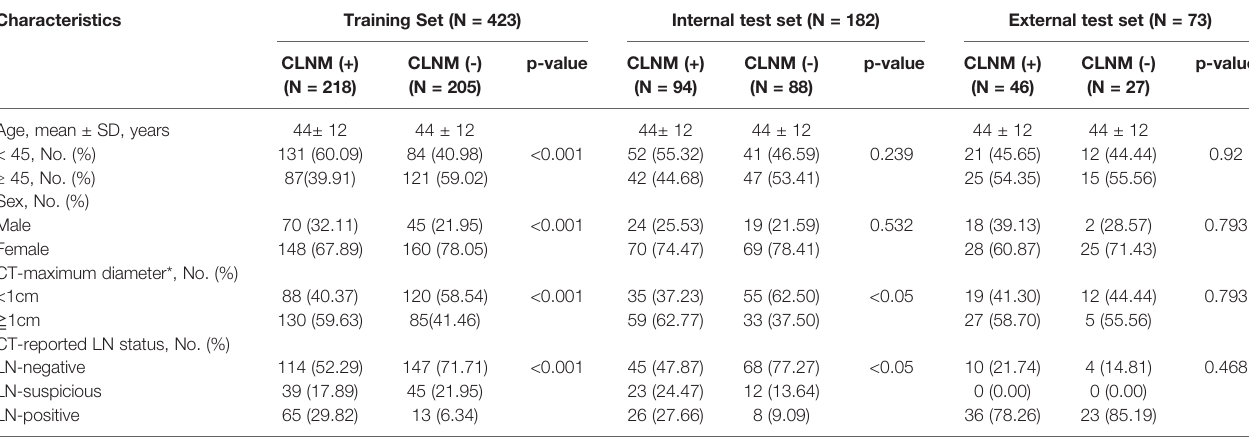
TABLE 1 | Clinical characteristics of patients in the training and test sets.